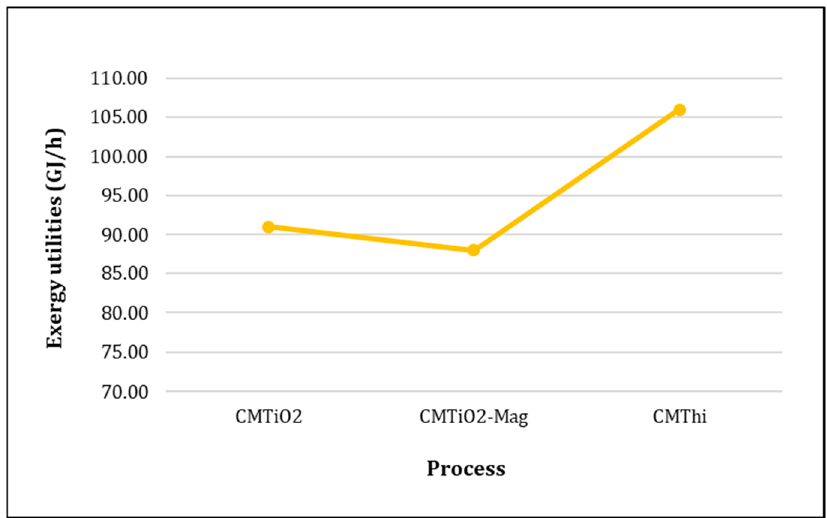
Figure 9. Comparison of exergy utilities for each processing route.